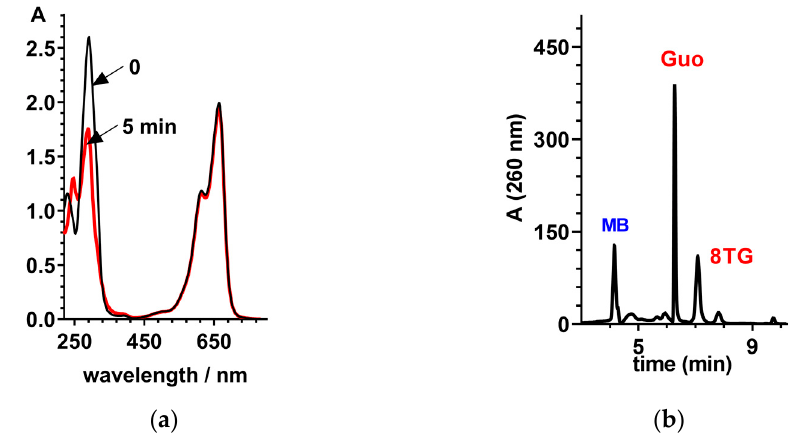
Figure 4. ( a ) UV absorption spectra recorded in the course of radiation of methylene blue (MB) and 8-TG with λ > 400 nm; ( b ) Chromatogram of the irradiated mixture.